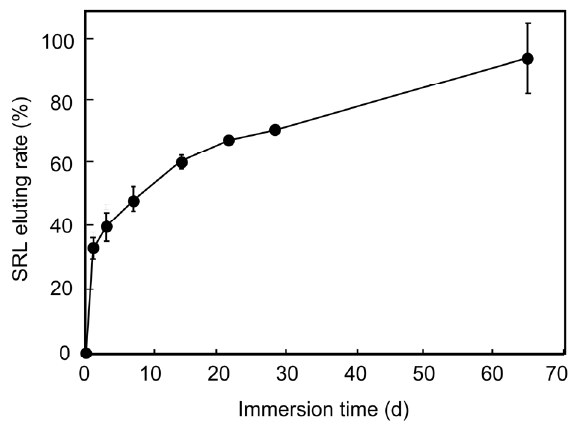
Figure 4. SRL-release profiles from the parylene C- and polymer-coated HF-treated stents after balloon expansion, in 37 °C PBS over 64 days. The data represent the mean value for n = 3 and error bars show the standard deviations of the means.